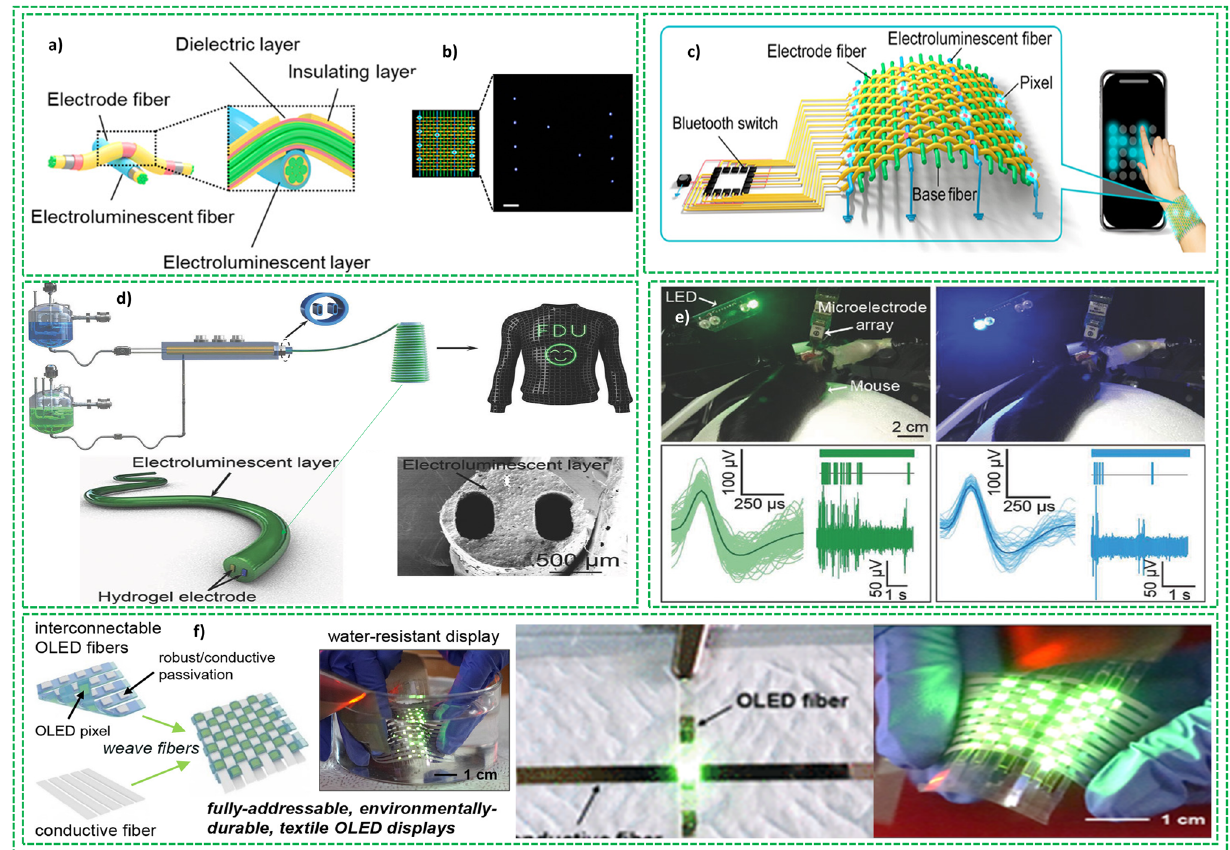
Fig. 18 a Schematic graphic of a pixel configuration in the electroluminescent fabric. b Diagram and picture of the electroluminescent fabric displaying the design “N.” c Representation of the smart electroluminescent fabric being functionalized by connecting Bluetooth. a – c Reprinted with permission from Ref. [204]. d Graphics representation of the instantaneous extrusion process and the light-emitting fiber. e Real-time brain- interfaced camouflage of the SEF under green and blue illumination. Top: Setup for recording neural activity in mouse. Middle: Color responses of a V1 neuron. Bottom: The electroluminescent textile controlled by the decoder light up in the same color as the exposed light Reprinted with permission from Ref. [20]. f Pictorial demonstration of the woven OLED textile display comprising of orthogonally organized arrays of inter- connectable OLED fibers and conductive fiber, OLED fiber perpendicularly placed to a conductive fiber for activating one-pixel, digital photo- graph of the working woven textile device comprising 10 × 10 fiber arrays by the passive matrix scheme Reprinted with permission from Ref. [205]. (Color figure